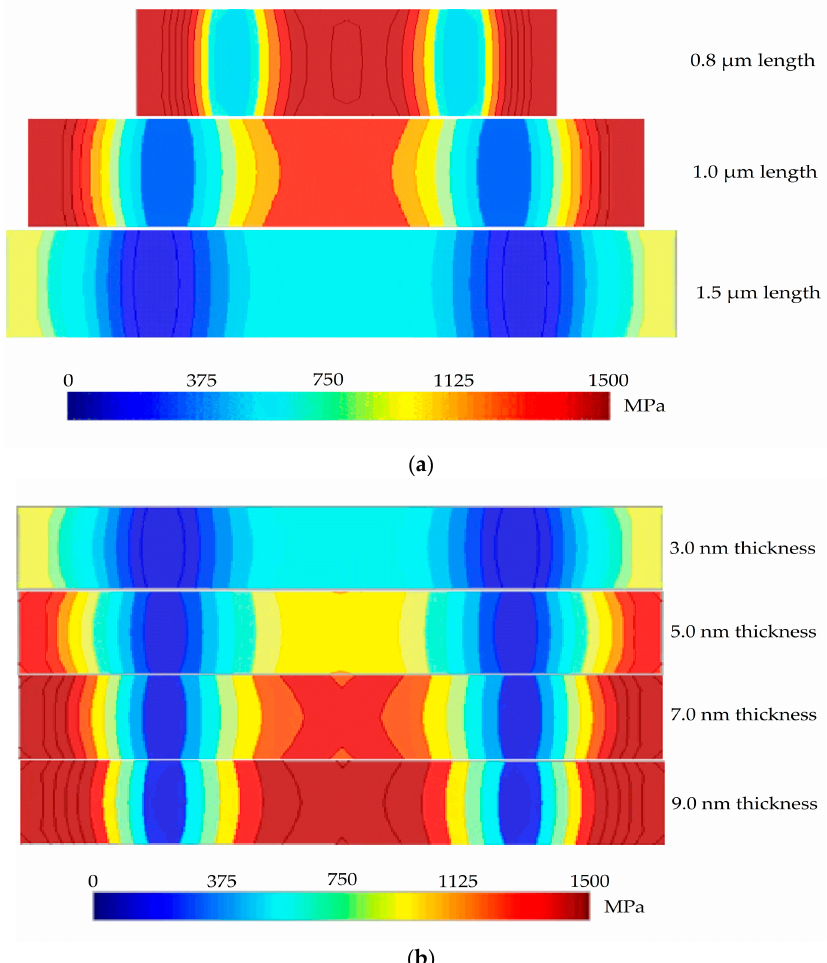
Figure 12. Von Mises stress contour plot from the top view (unit: MPa) with a variation of: ( a ) intact graphene beam length; ( b ) intact graphene beam thickness.